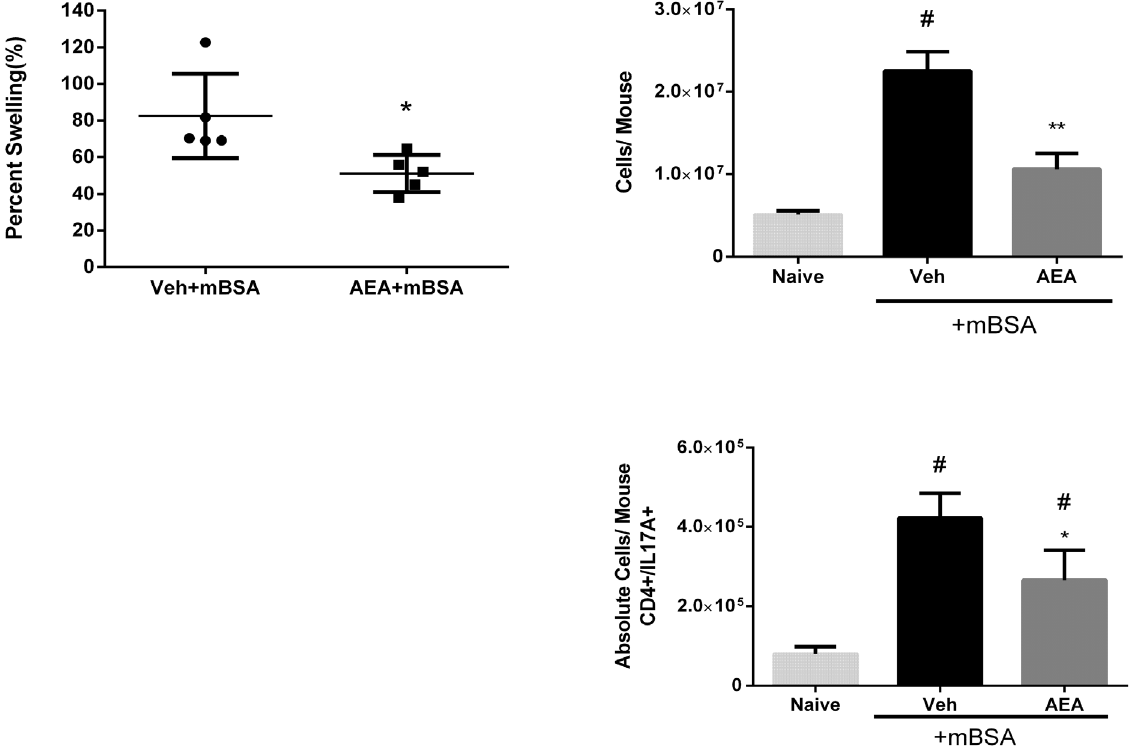
Figure 1. AEA ameliorates mBSA-Induced delayed hypersensitivity. Mice were sensitized to mBSA by giving an injection of 150 m g of mBSA emulsified into CFA into each hind flank. They were treated with AEA or vehicle on days 5 and 6 after sensitization and rechallenged with 200 m g mBSA into the right footpad and PBS in the left footpad. [A] The footpad swelling was measured as described in Methods. Graph representative of 3 independent experiments with n=5. *p , 0.05 compared to Veh. [B] Cells were harvested from draining lymph nodes [LN] and viable cells counted using trypan blue exclusion. Cell numbers are representative of 2 independent experiments with n=5. # p , 0.05 compared to naı¨ve. **p , 0.05 when compared to vehicle. [C] Cells from the LN were cultured for 4 hours in the presence of PMA, Ionomycin, and Golgi Plug and stained for IL-17 secreting cells. Graph is representative of 3 independent experiments with n=3. # p , 0.05 compared to naı¨ve; *p , 0.05 compared to vehicle.